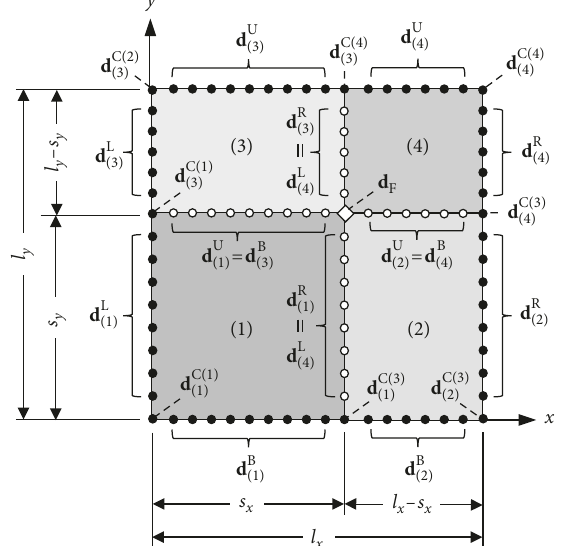
Figure 4: Four-element model for a rectangular plate subjected to a stationary point force F k . point force F k is located, • the interim nodes without external (cid:31) ○